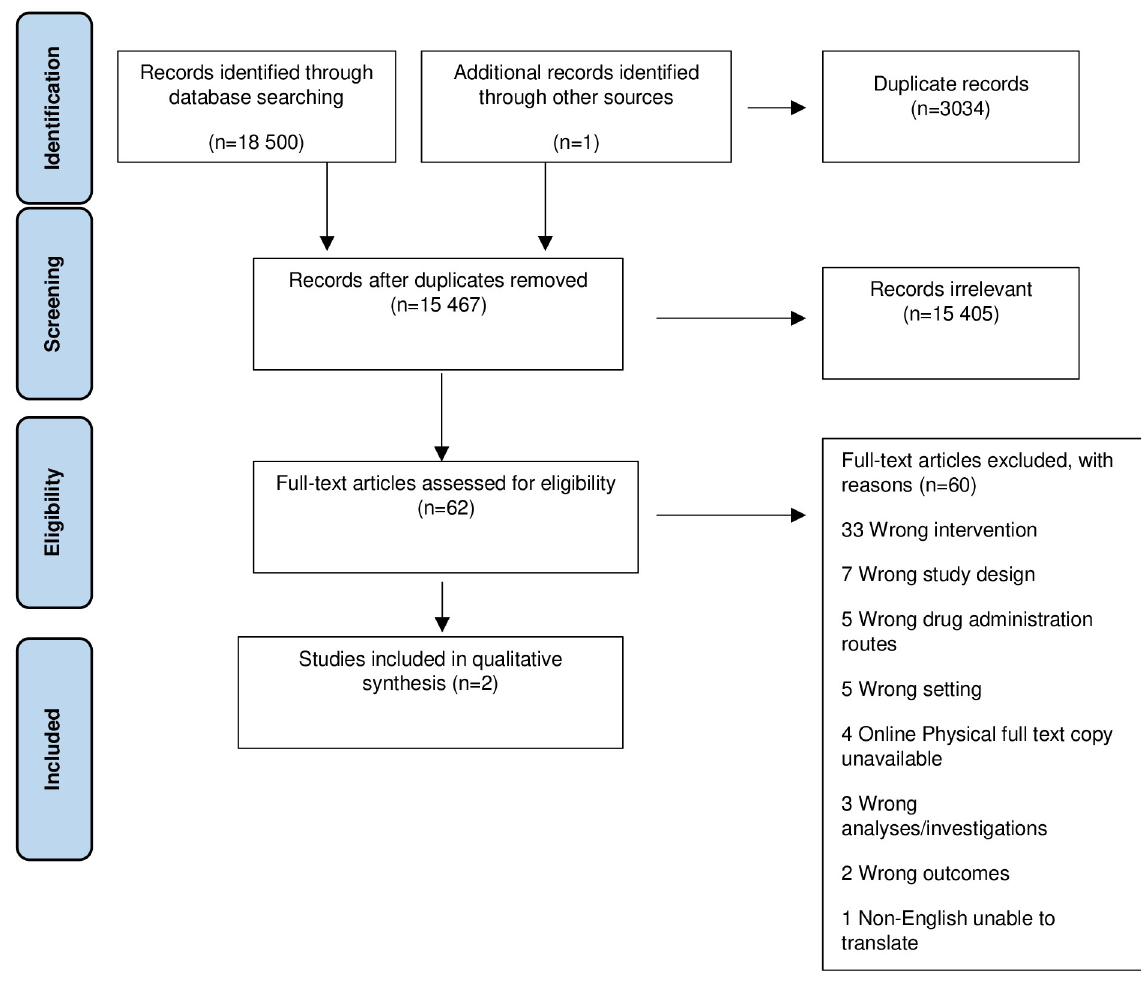
Fig 1. PRISMA flow diagram.